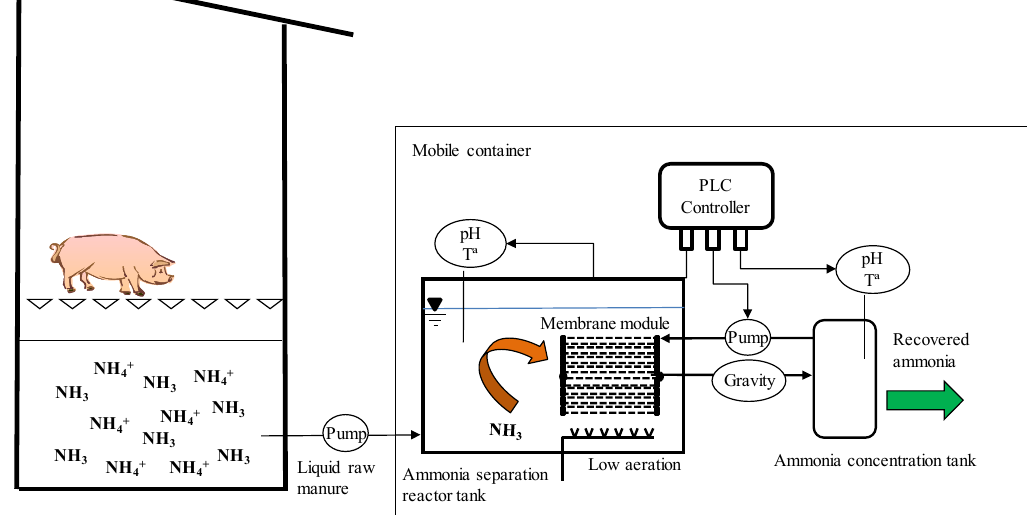
Figure 1. Scheme of the pilot plant.